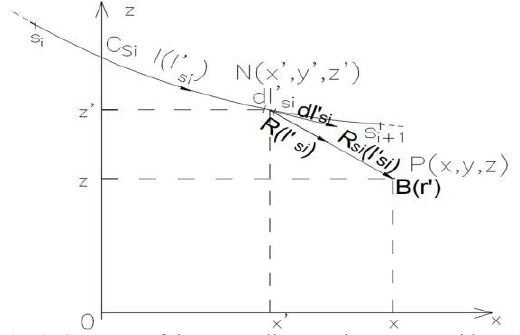
Fig. 2. Segment of the power line conductor – consider system.